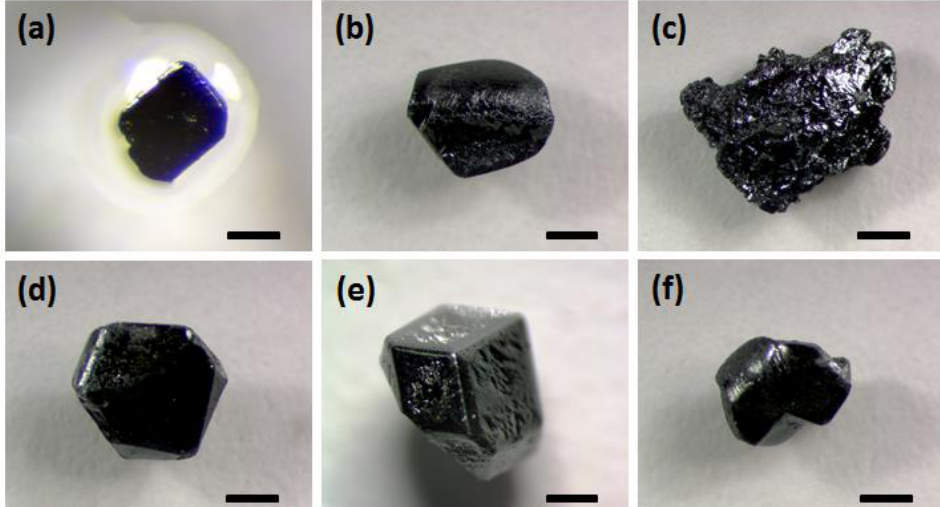
Figure 1. Optical microscope images (scale bar: 1 mm) of the hybrid perovskite crystals grown in γ -butyrolactone (GBL) with acid additives: ( a ) Crystal O, without additive, ( b ) crystal A nucleated and grown with acetic acid, ( c ) crystal B nucleated and grown with formic acid, ( d , e ) crystals B seed nucleated with of acetic acid and grown in the presence of formic acid, and ( f ) crystal C nucleated and grown with trifluoroacetic acid.